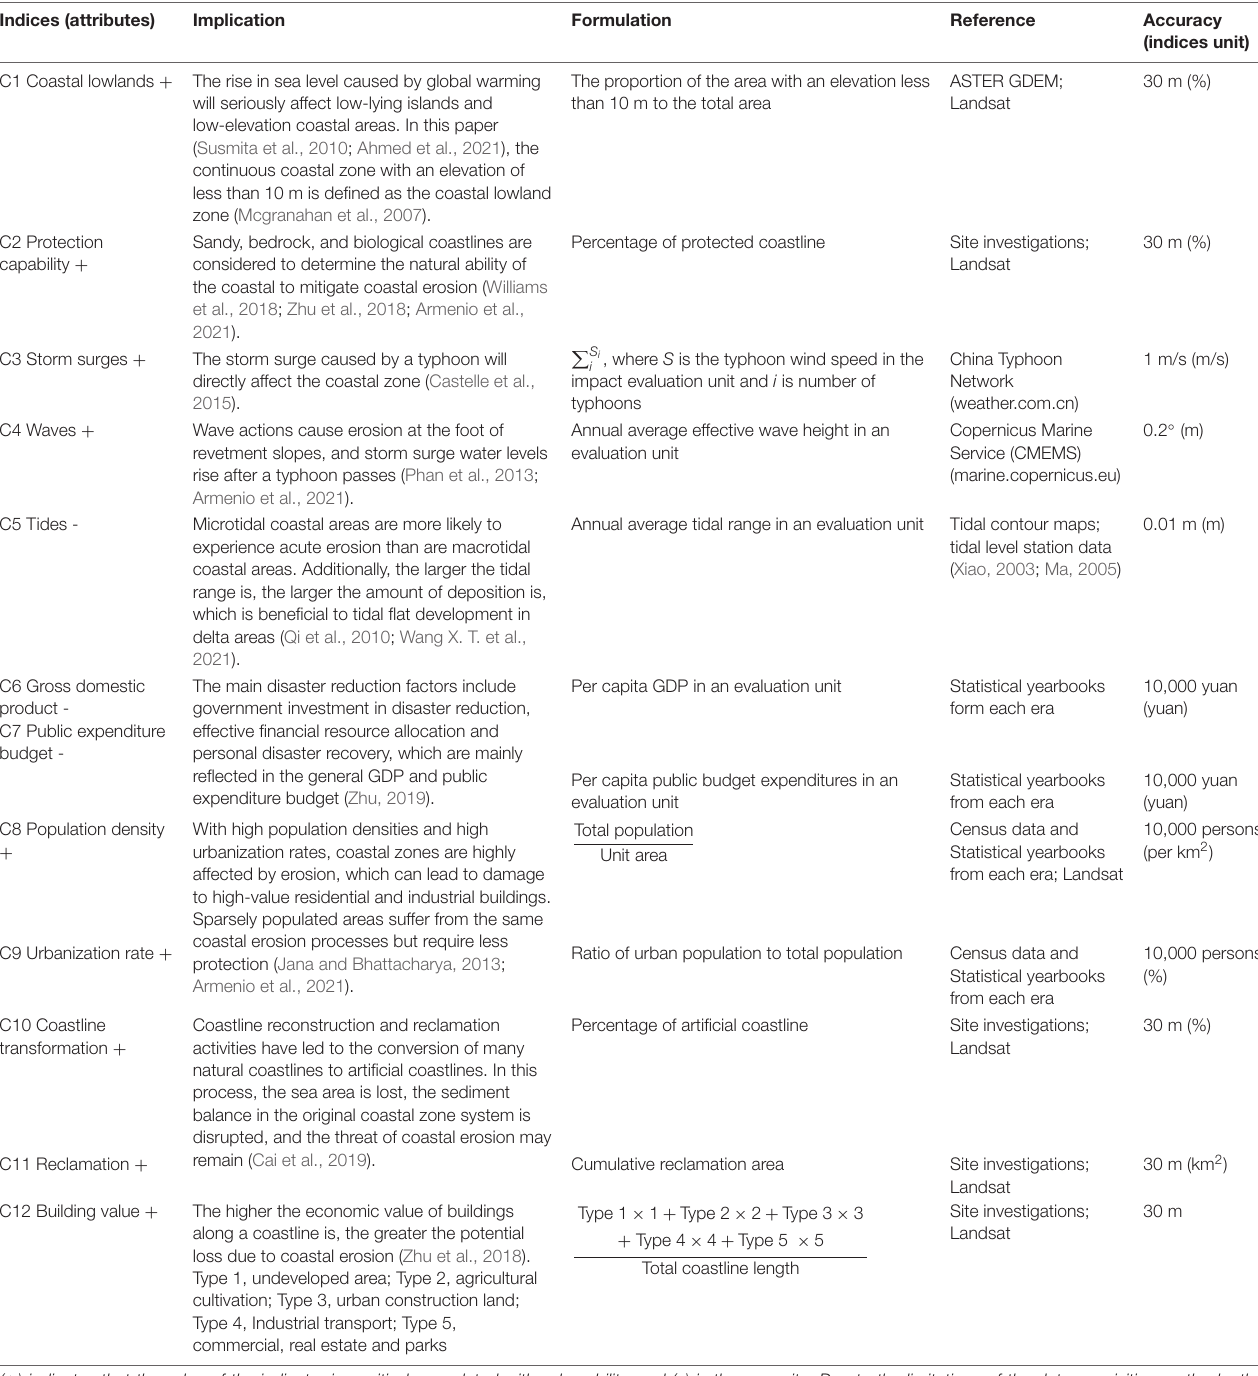
TABLE 1 | Indicators used in the integrated coastal erosion vulnerability assessment. Indices